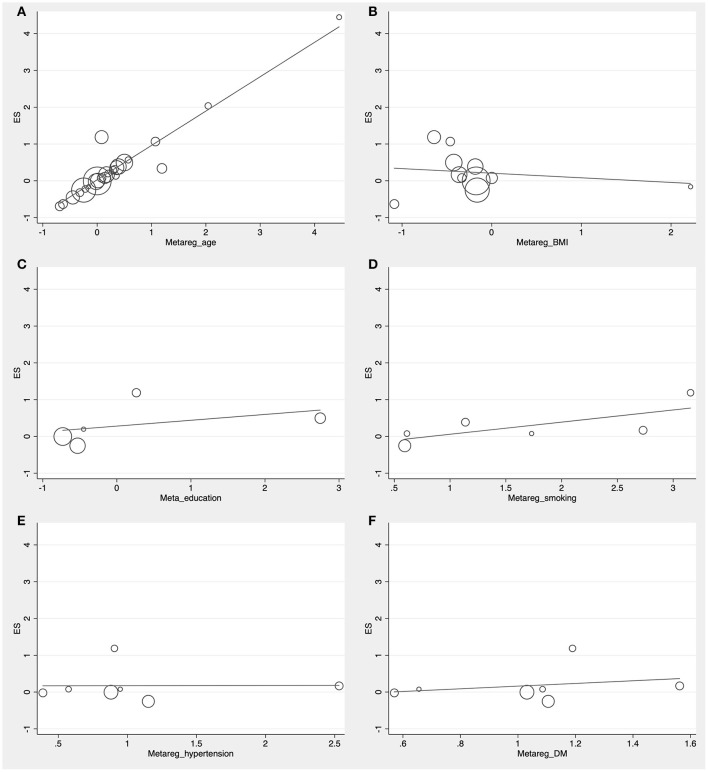
Forest plots of the meta-regression analyses on age (A), body mass index (B), education (C), smoking (D), hypertension (E), and diabetes mellitus (F) in relation to LDL-c levels between Alzheimer's disease and non-dementia. ES, effect size.